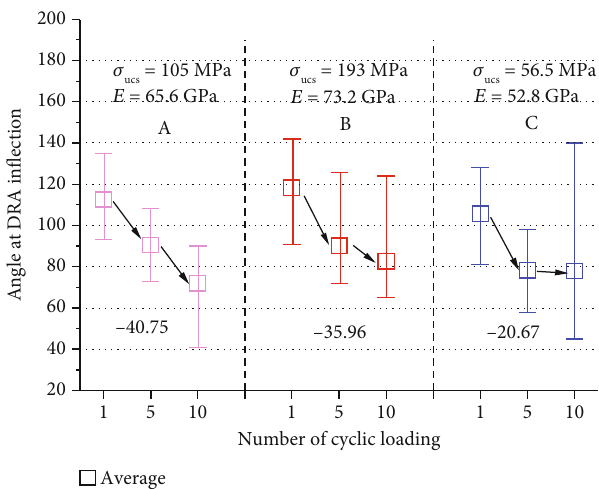
Figure 9: Variation of the angle at DRA in fl ection under di ff erent cyclic load times.